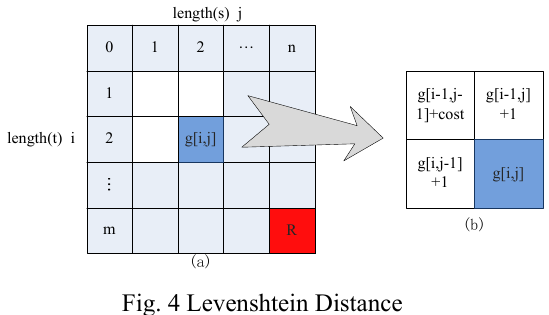
Fig. 4 Levenshtein Distance